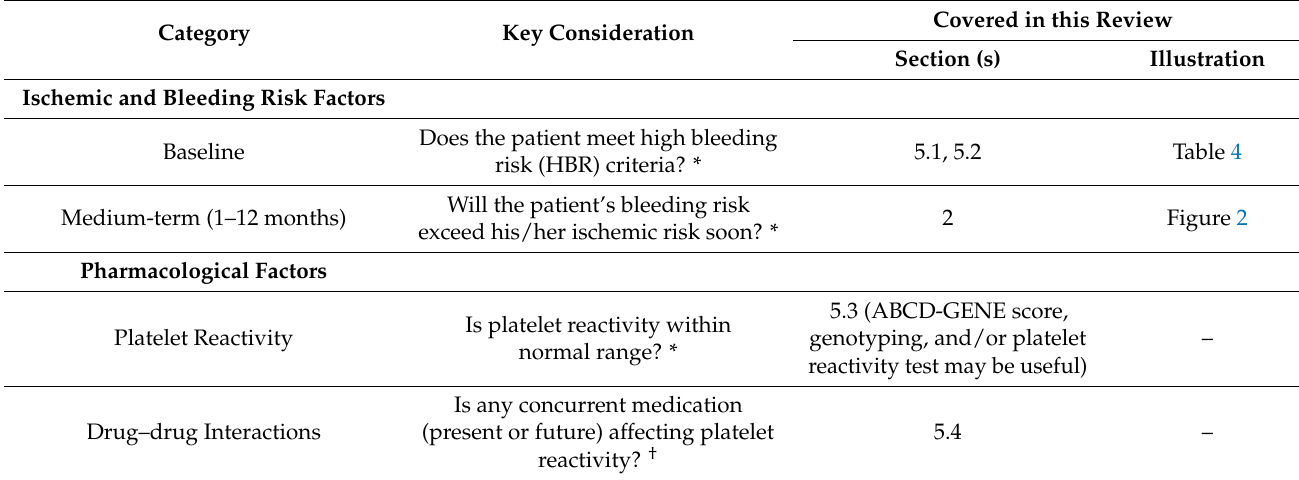
Table 5. Key patient considerations for reducing antiplatelet therapy (APT)